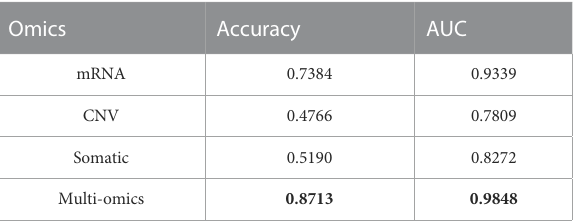
TABLE 3 Results of multi-omics data compared with single-dimensional